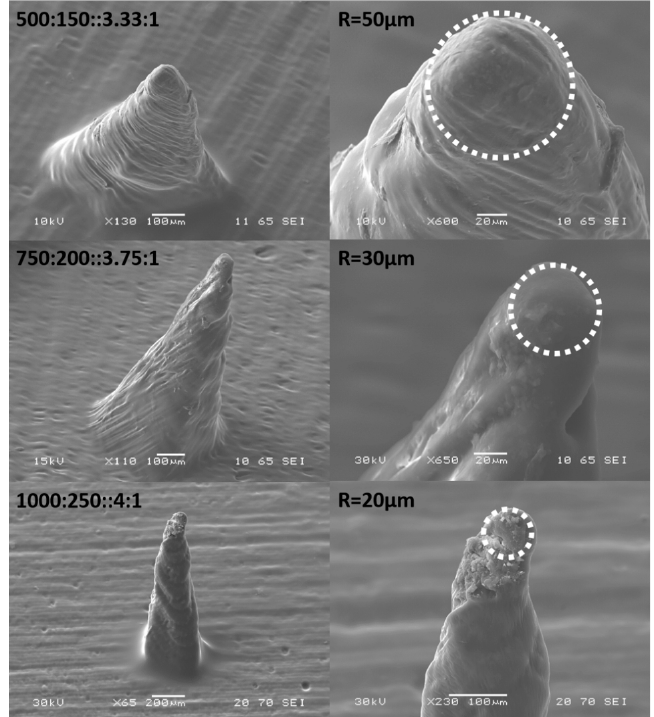
Figure 14. Effect of aspect ratios of 3.33, 3.75 and 4 on the 3D printed needles. Radius of curvature of 50 μm, 30 μm and 20 μm are obtained for aspect ratios of 3.33, 3.75 and 4 respectively.